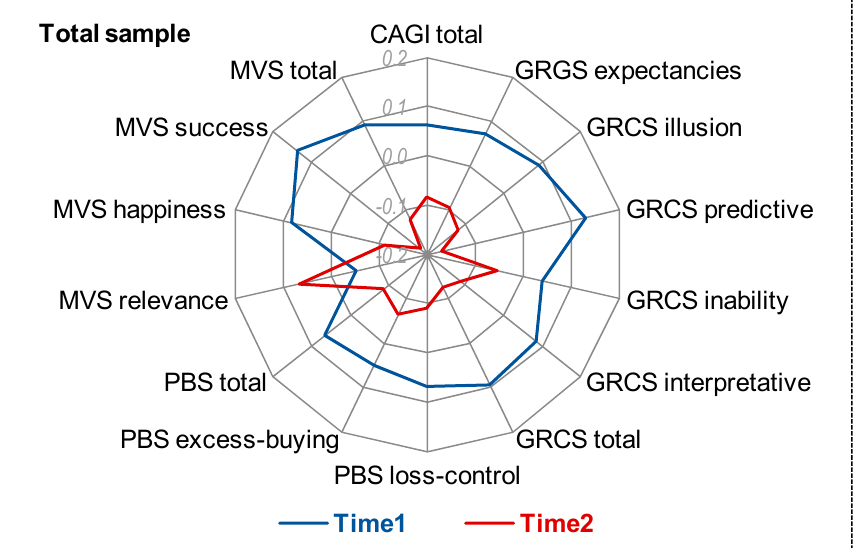
Figure 1. Radar chart (standardized means).CAGI: Canadian Adolescent Gambling Inventory. GRCS: Gambling Related Cognitions Scale. PBS: Pathological Buying Screener. MVS: Materialism Values Scale.